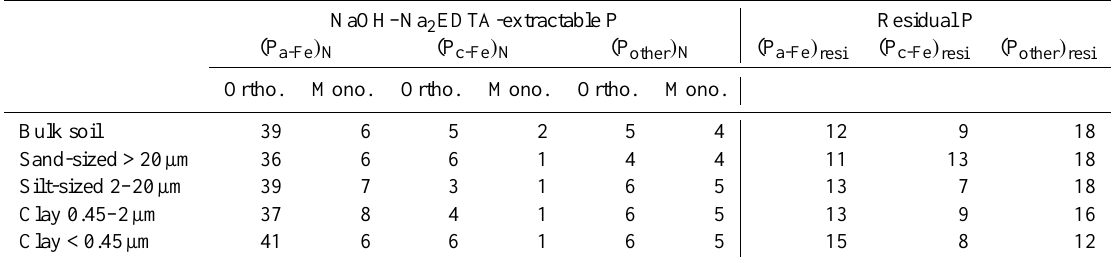
Table 1. NaOH–Na 2 EDTA-extractable P and residual P distribution (%, with respect to total P of each soil aggregate-sized fraction) associ- ated with amorphous and crystalline oxides, and other soil compounds as shown in Eqs. (1–6). NaOH–Na 2 EDTA-extractable P Residual P (P a-Fe ) N (P c-Fe ) N (P other ) N (P a-Fe ) resi (P c-Fe ) resi (P other ) resi Ortho. Mono. Ortho. Mono. Ortho. Mono. Bulk soil 39 6 5 2 5 4 12 Sand-sized >20µm 36 6 Silt-sized 2–20µm 39 7 Clay 0.45–2µm 37 Clay <0.45µm